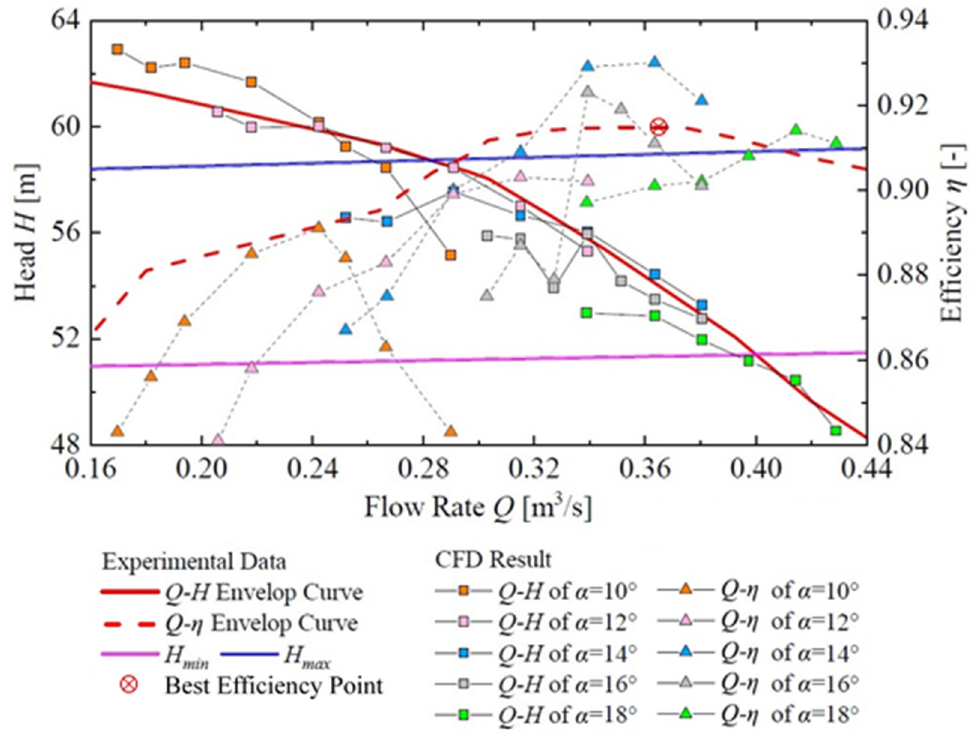
Figure 4. Experimental–numerical comparison of energy performance in pump mode.